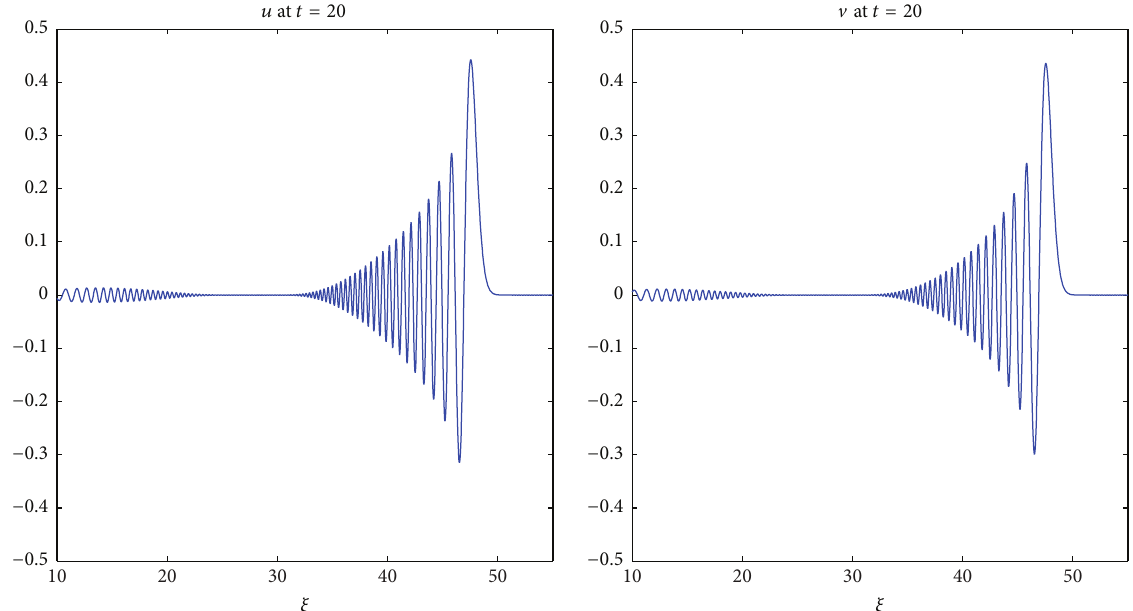
Figure 11: Evolution of a Gaussian pulse over a flat channel without surface tension effect. Parameters: 𝛼 = 0 , 𝛽 = 0.01 , and 𝜎 = 0